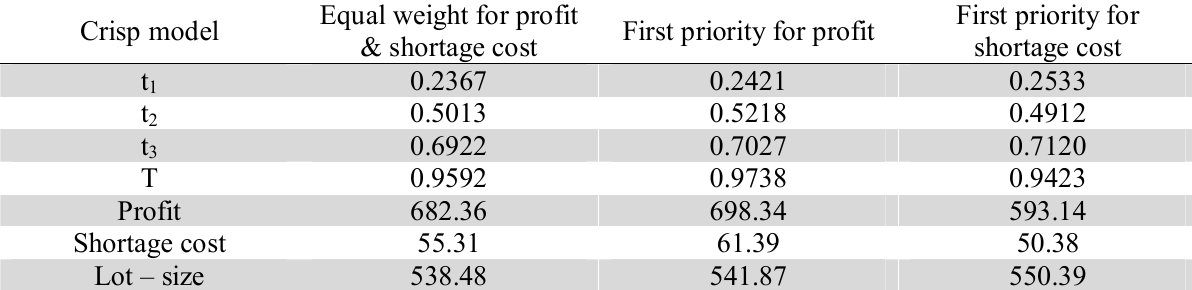
Results for Crisp